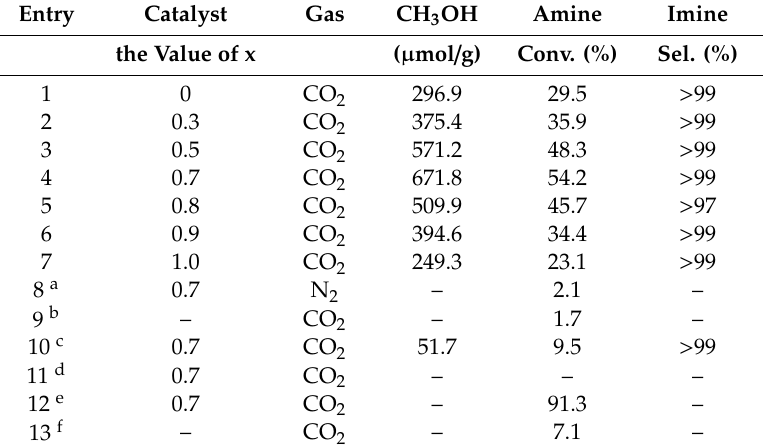
Table 2. Photocatalytic activity of di ff erent nanoparticles.